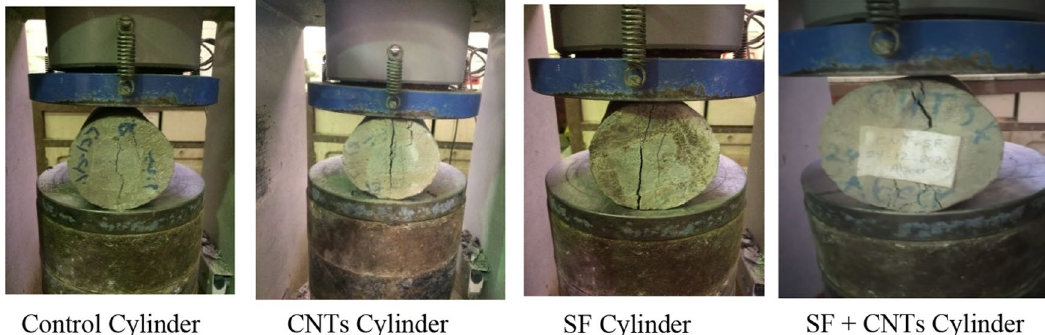
Fig. 15 Failure modes of the cylinders made from various mixtures